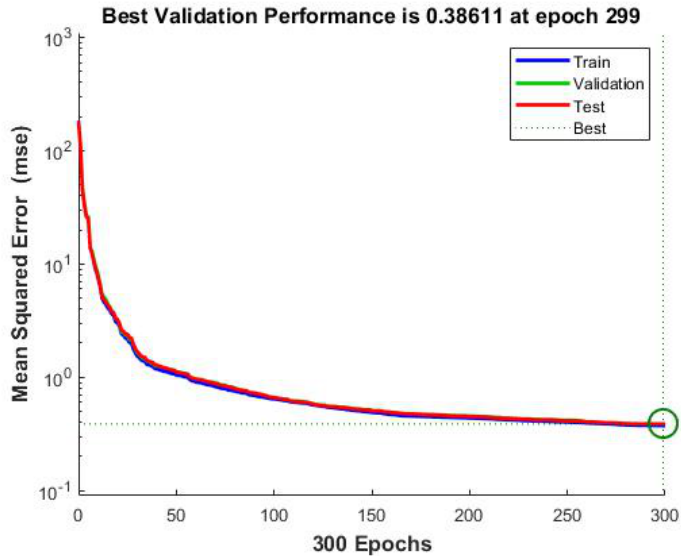
Figure 8. Change of MSE from the beginning to the 299th epoch.